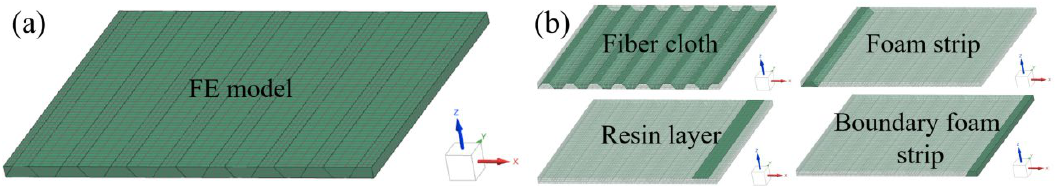
Figure 4. The FE model of the corrugated sandwich panel. ( a ) The assembly of the FE model. ( b ) Typical components of the FE model.